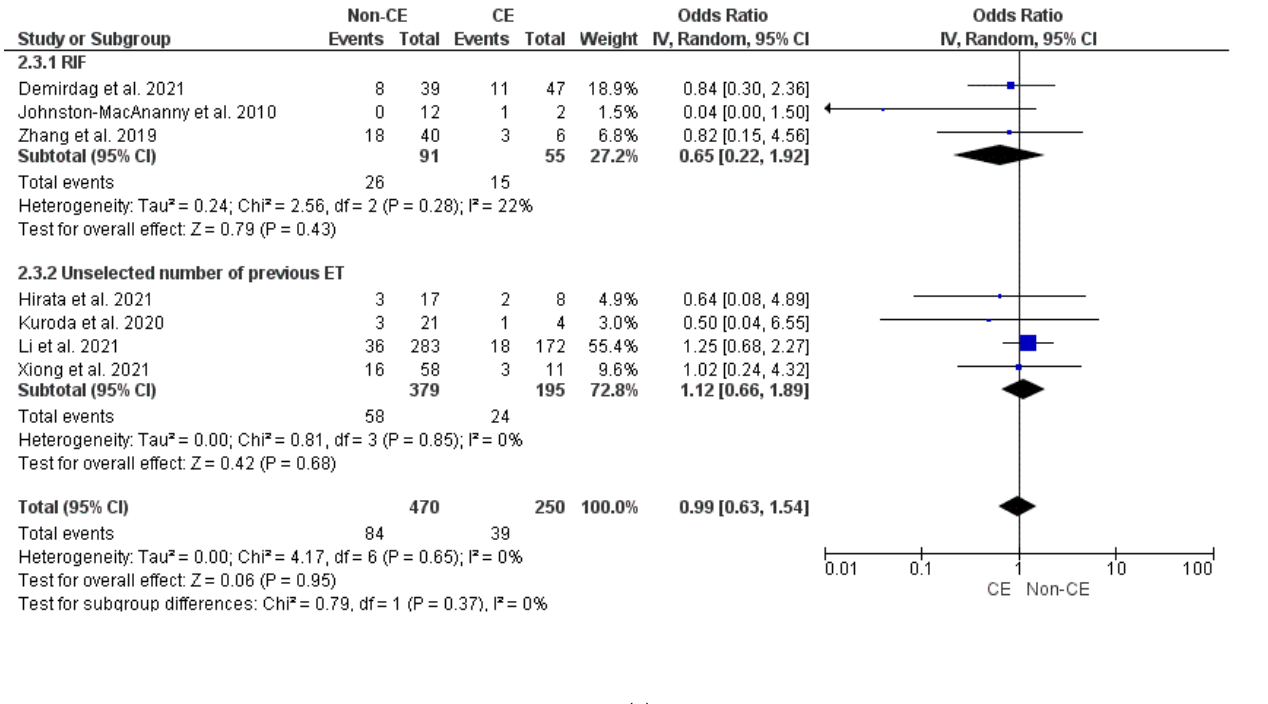
Figure 2. Pooled data analysis comparing CE versus non-CE: ( a ) ongoing pregnancy rate/live birth rate; ( b ) clinical pregnancy rate; ( c ) miscarriage rate [6,8 – 12,32 – 34].